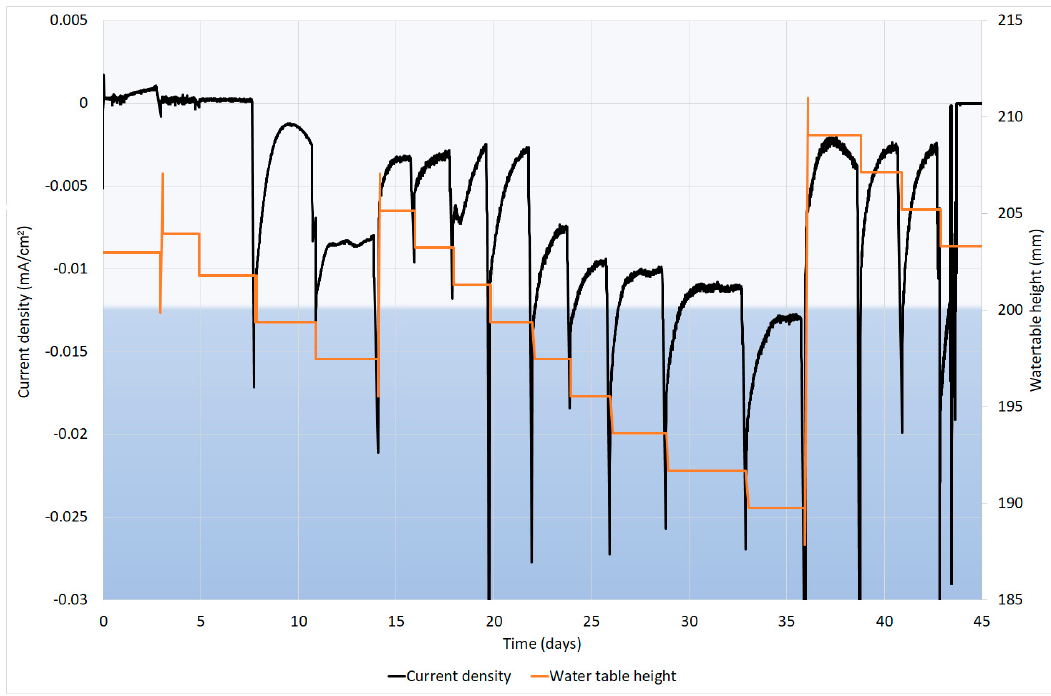
Figure 3. The current density and water level in cathode chamber. The black line shows the current density and the orange line shows the water table height in the cathode chamber. The water level is affected by the sample collection and increases on days 14 and 36 are related to the adding of new substrate. The light blue background represents the height of the electrode from the bottom of the reactor.